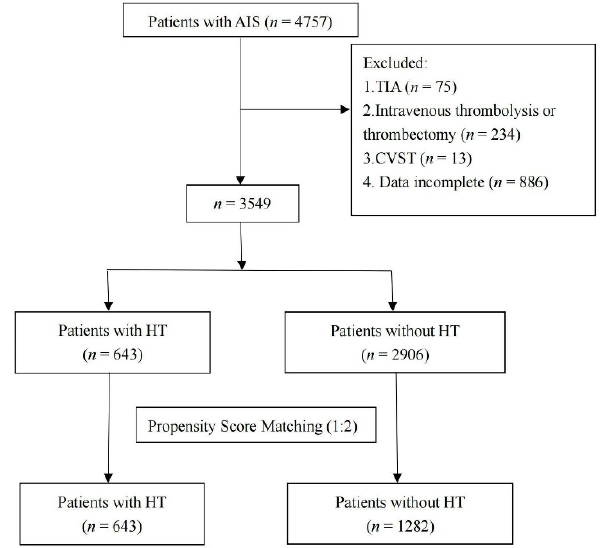
Figure 1. Flow chart showing the patient’s selection process. AIS, acute ischemic stroke; TIA, transient ischemic attack; CVST, cerebral venous sinus thrombosis; HT, hemorrhagic transformation.